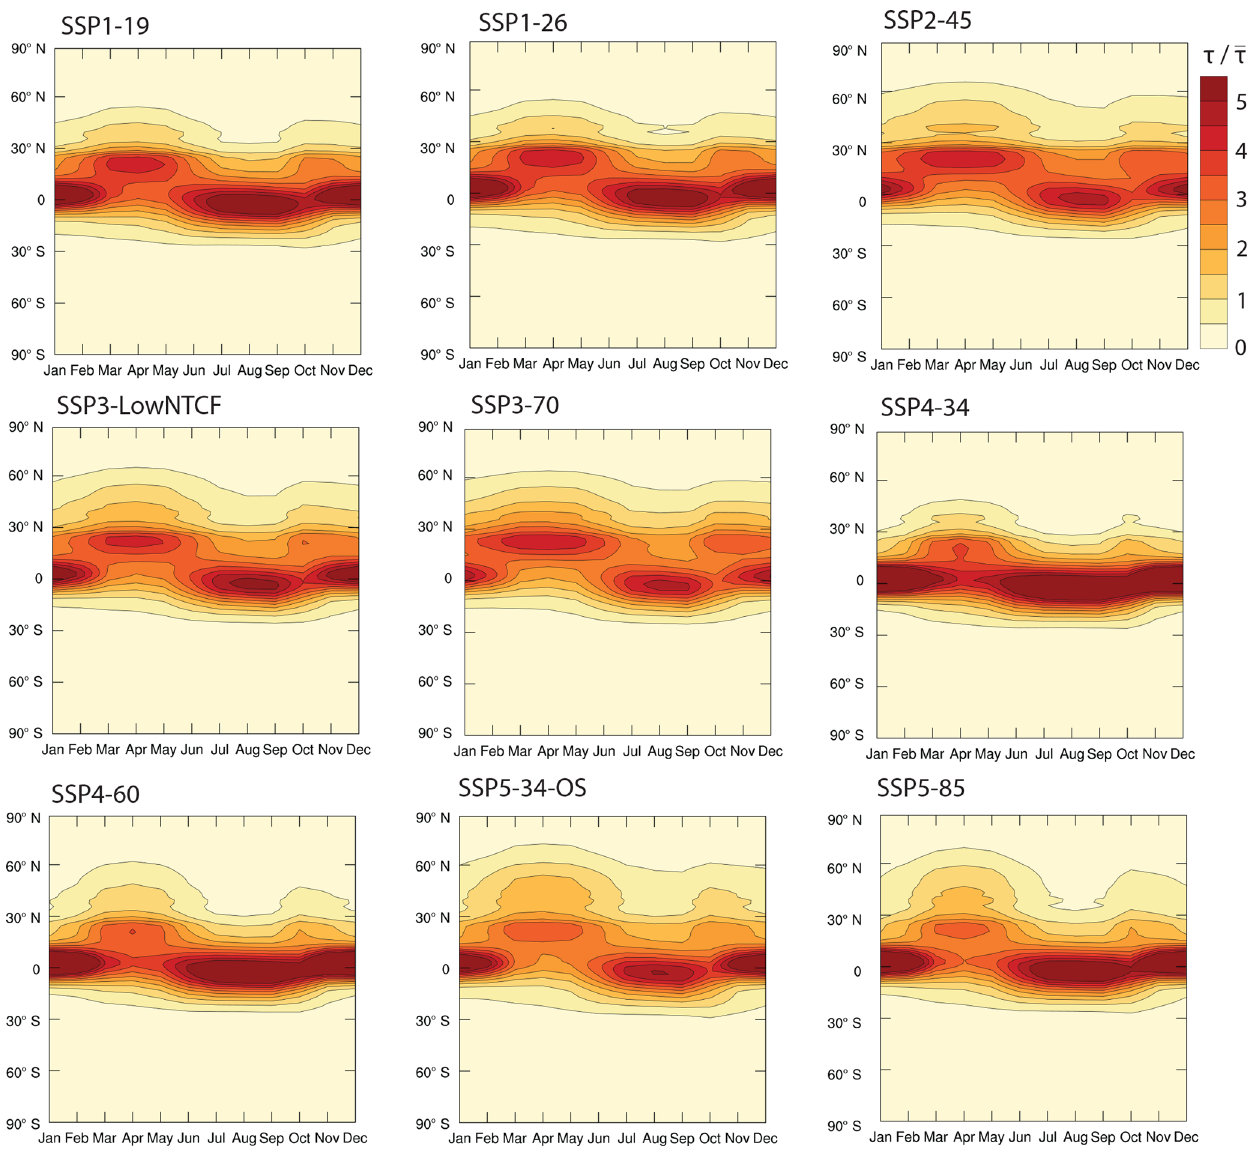
Figure 5. Spatial patterns for the mid-2090s in the MACv2-SP interpretation of CMIP6 scenarios. Shown are the annual cycles of the zonal means in τ at 550nm weighted by the global mean τ for each month and emission scenario of